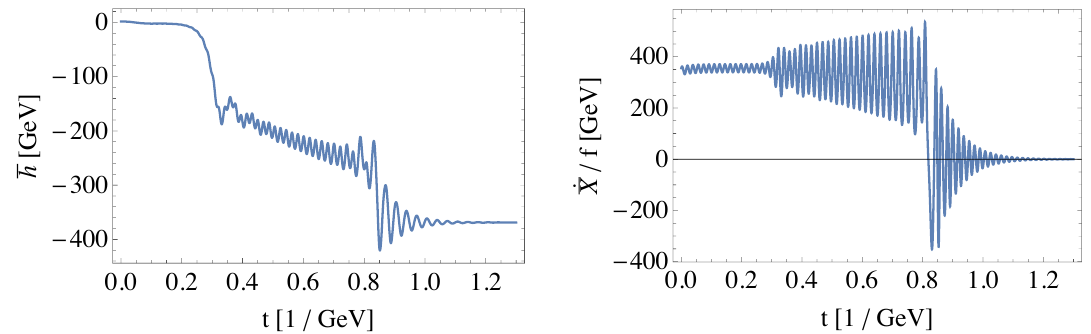
Figure 12 . Another stopping mechanism. The left and the right panels show the evolution of (cid:22) h and _(cid:22) X=f ,